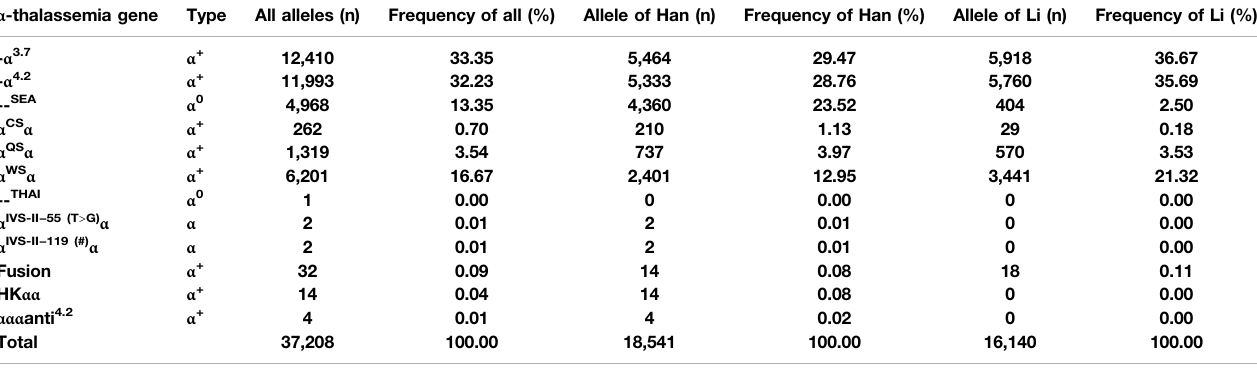
TABLE 3 | Allele frequency of α -thalassemia mutations in the population of childbearing age in the Hainan Island. α -thalassemia gene